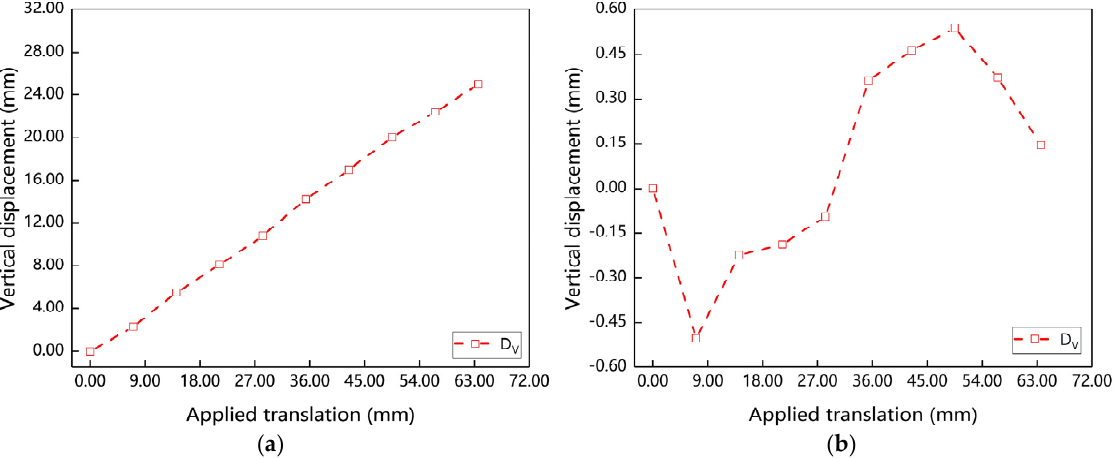
Figure 13. Vertical displacement correction results: ( a ) measured vertical displacement before cor- rection; ( b ) vertical displacement before correction. tion; ( b ) vertical displacement before